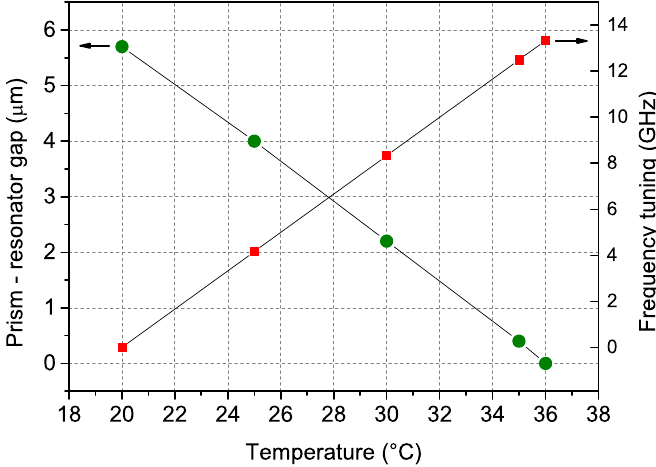
Figure 2. Temperature dependence for the coupling prism-WGMR gap (left scale), measured interferometrically; and for the WGMR mode frequency tuning (right scale).